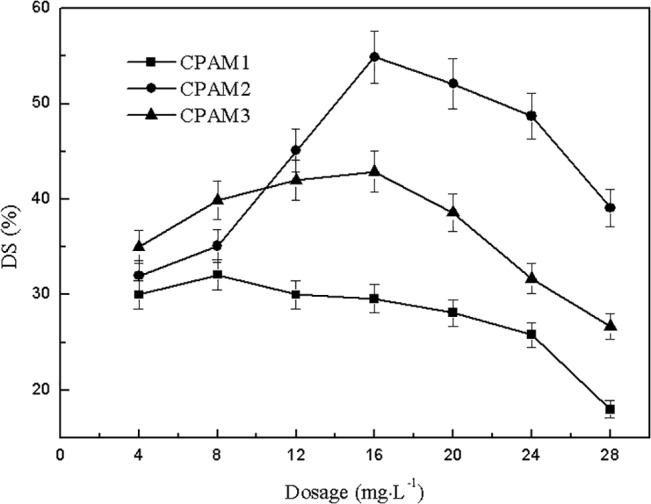
Effect of dosage on DS.